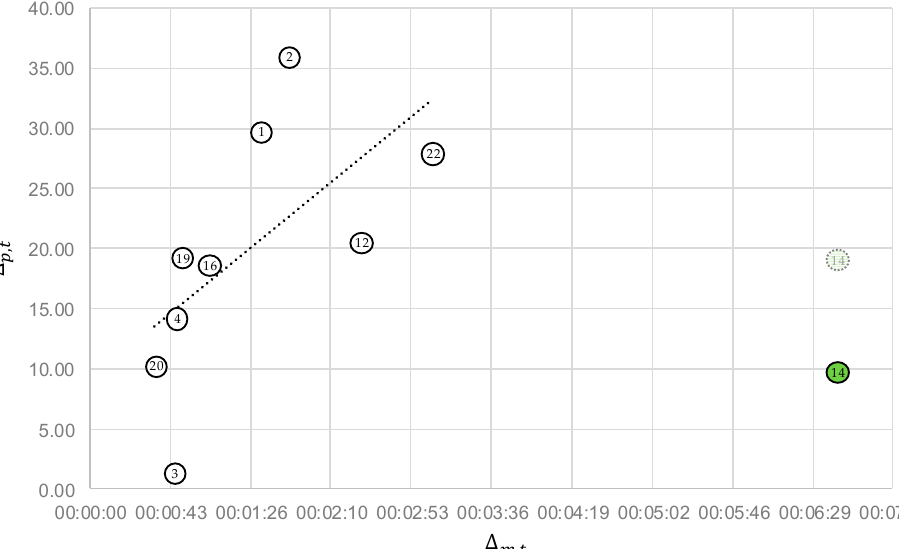
Figure 7. Comparison between the time for the pressure and the refill mass flow change.